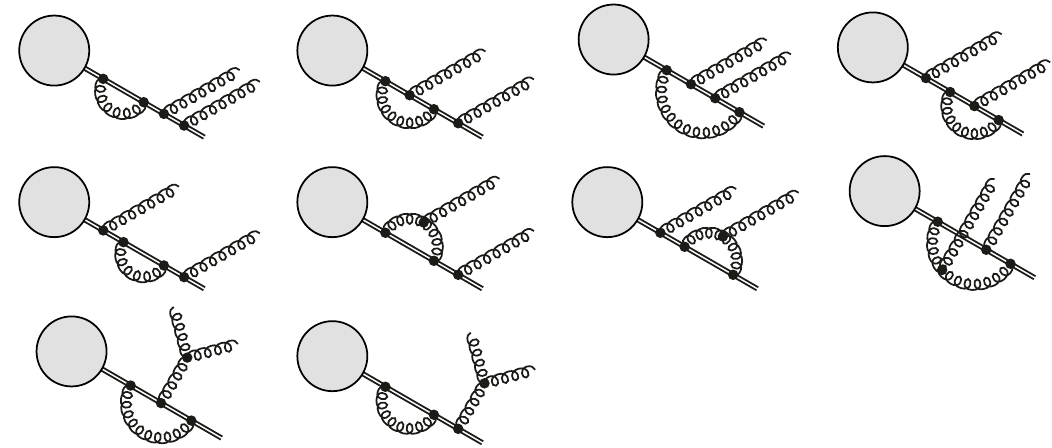
Figure 3 . Diagrams with two soft-gluon emissions from a single Wilson line (denoted by a double line) that yield scaleless integrals assuming that the emitting hard parton is massless. Diagrams which only differ by a permutation of the external gluons are displayed only once. The shaded circle represents the reduced amplitude on which the soft current acts through colour-charge operators.